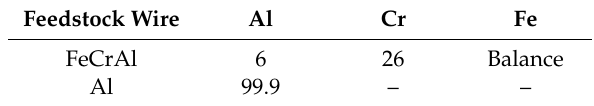
Table 1. Chemical composition of the spraying wires FeCrAl and Al